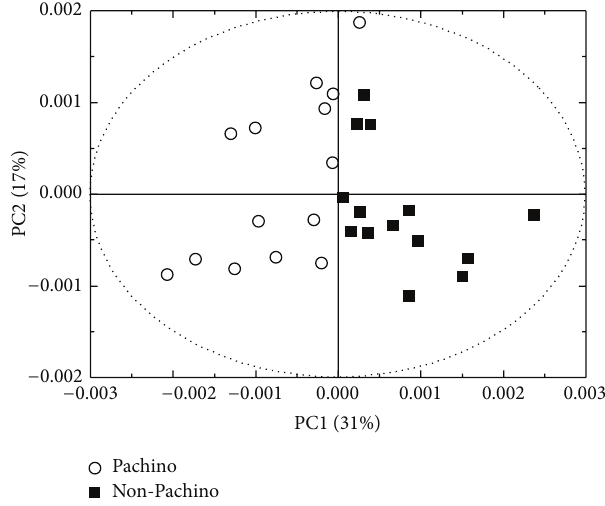
Figure 3: Score plot of the PCA analysis performed on cherry tomato samples. The Principal Component 1 (PC1) discriminates between Pachino and non-Pachino cherry tomatoes sample.